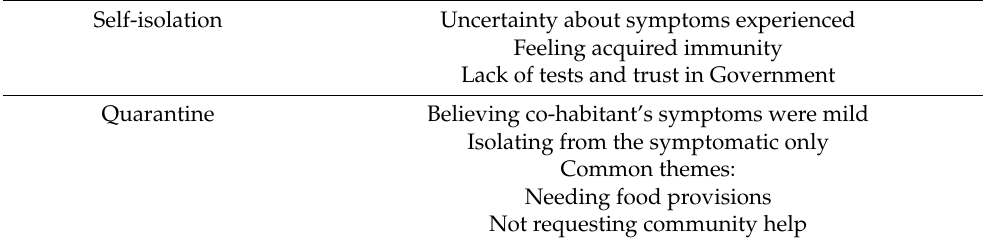
Table 7. Themes identified for SI and